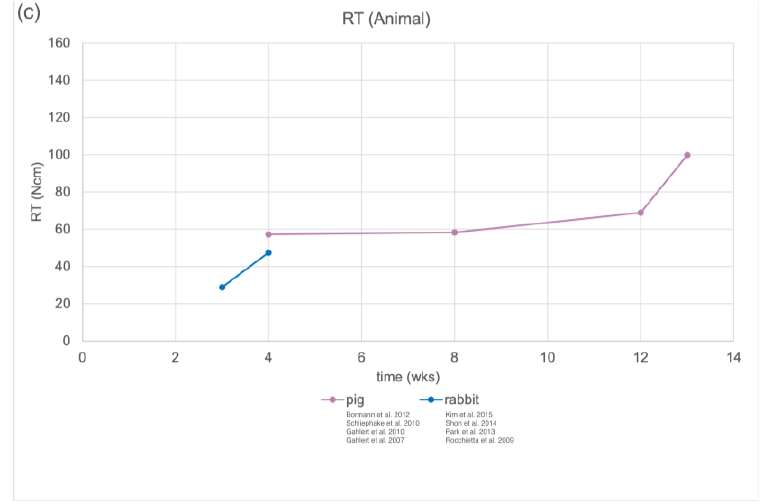
Figure 4. Removal torque (RT) around zirconia implants obtained in preclinical studies. ( a ) RT of all included studies, ( b ) RT pooled by surface treatment of zirconia implants and ( c ) RT pooled by animal model.